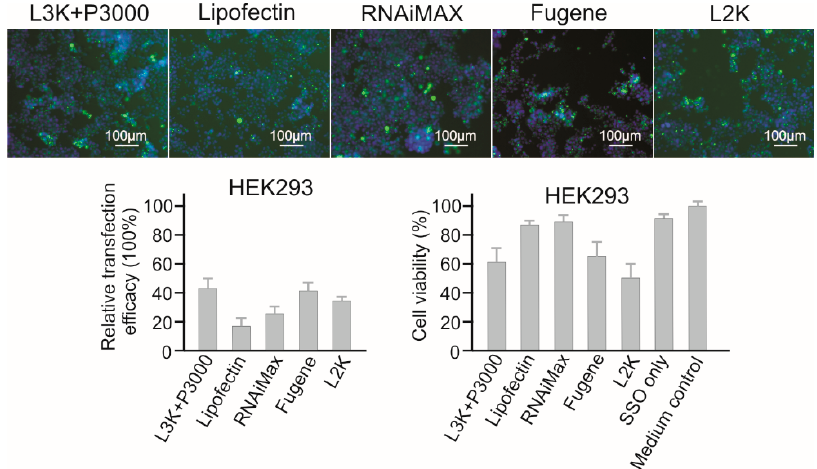
Figure 9. In vitro transfection efficiency and cytotoxicity of different transfection reagents in HEK293 cells. L3K: Lipofectamine 3000, L2K: Lipofectamine 2000.